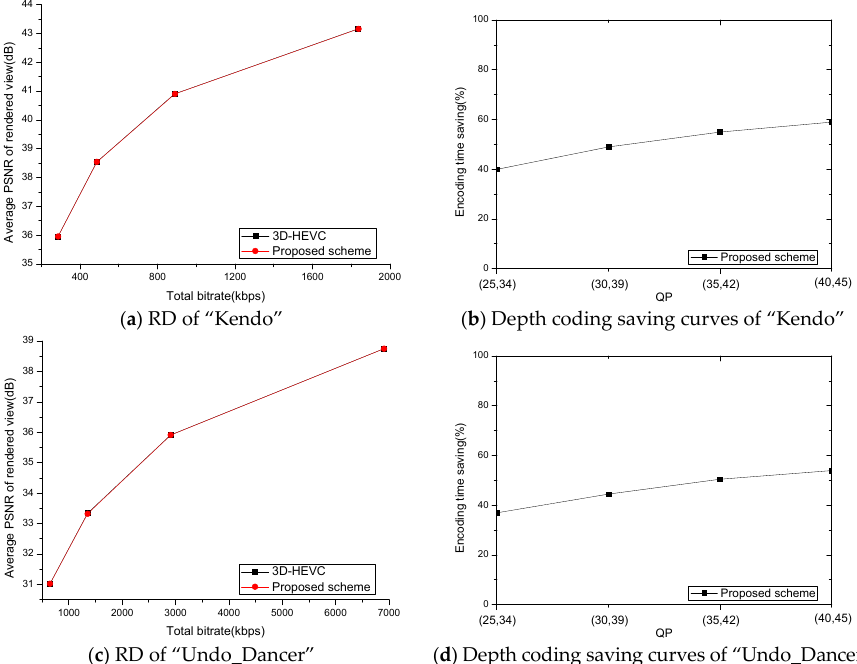
Figure 4. RD performance and depth map time saving under different QPs (25, 34), (30, 39), (35, 42), and (40, 45) for the “Random Access” condition. Information 2019 , 10 , x FOR PEER REVIEW